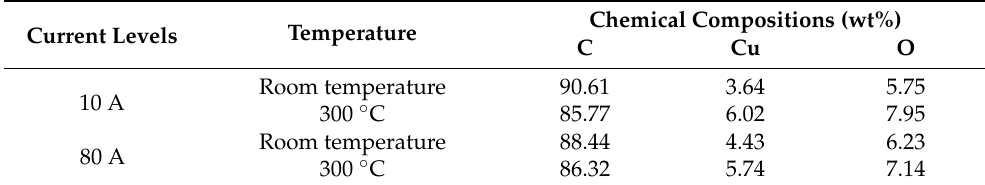
Table 3. XPS quantitative analysis of constitutions on the carbon surface under different interface